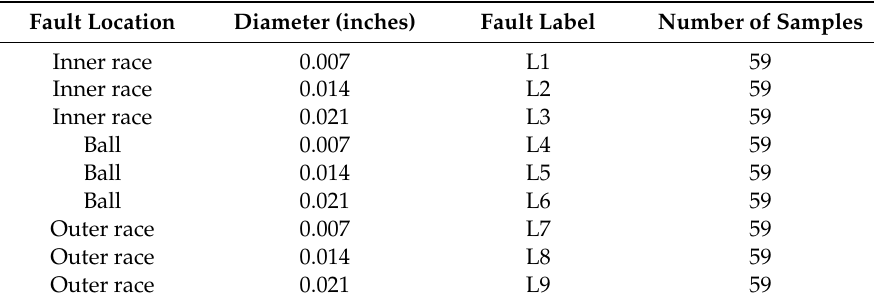
Table 2. Center frequencies with di ff erent K